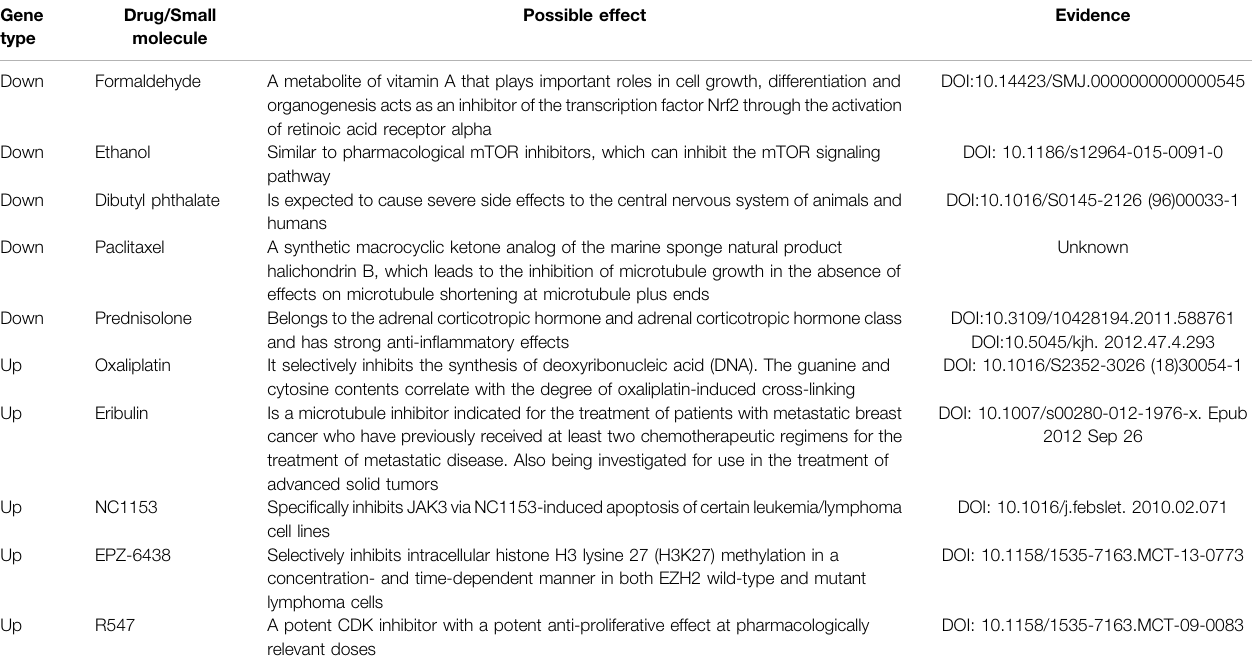
TABLE 2 | Potential DLBCL treatment